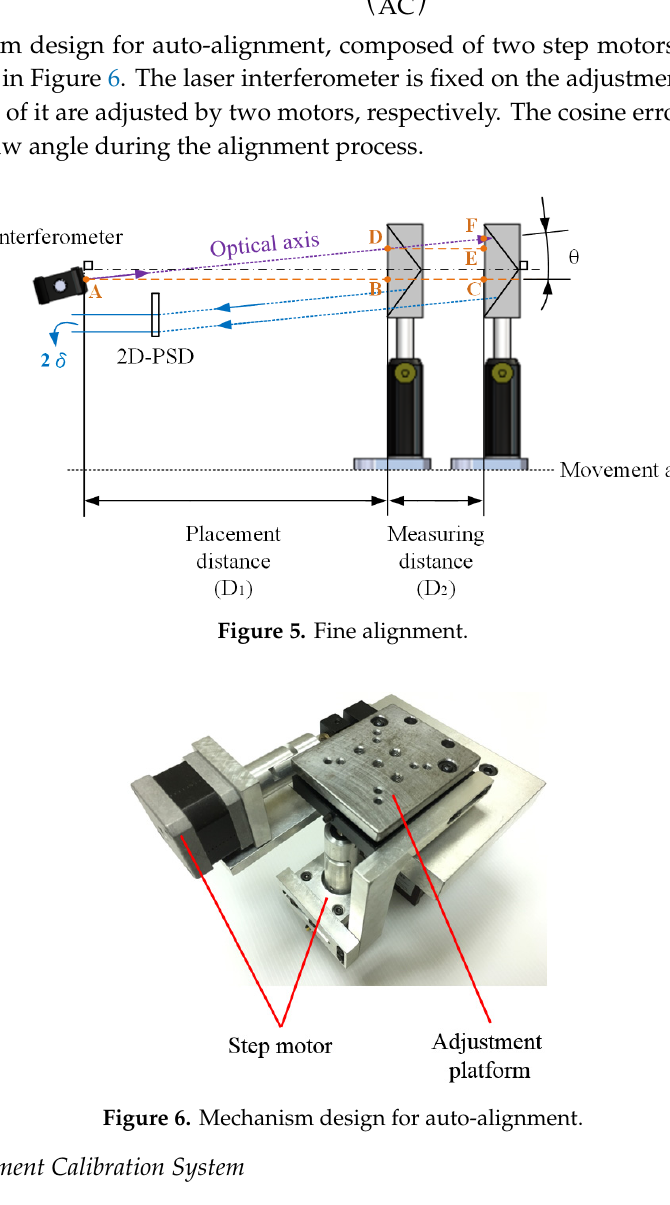
Figure 6. Mechanism design for auto-alignment.